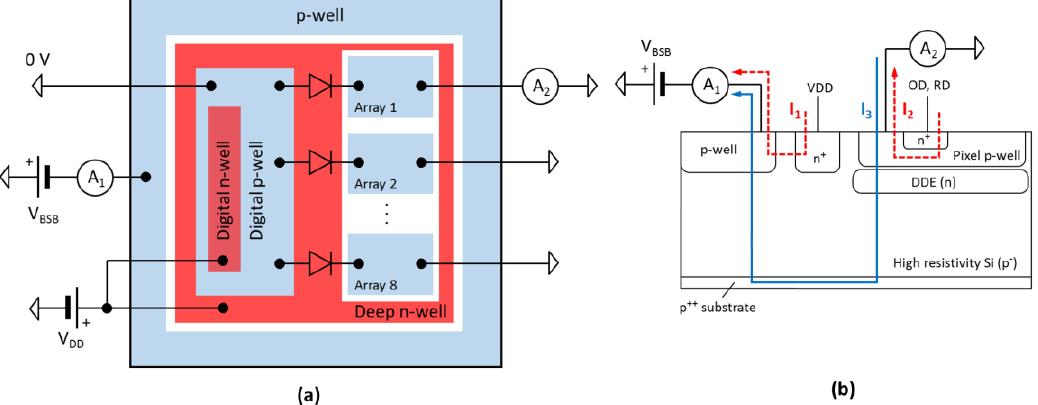
Figure 7. Simplified electrical diagram for the reverse current measurements ( a ) and the current components ( b ). The total substrate current I BSB is measured by the current meter A 1 and the substrate current of the individual arrays by A 2 .